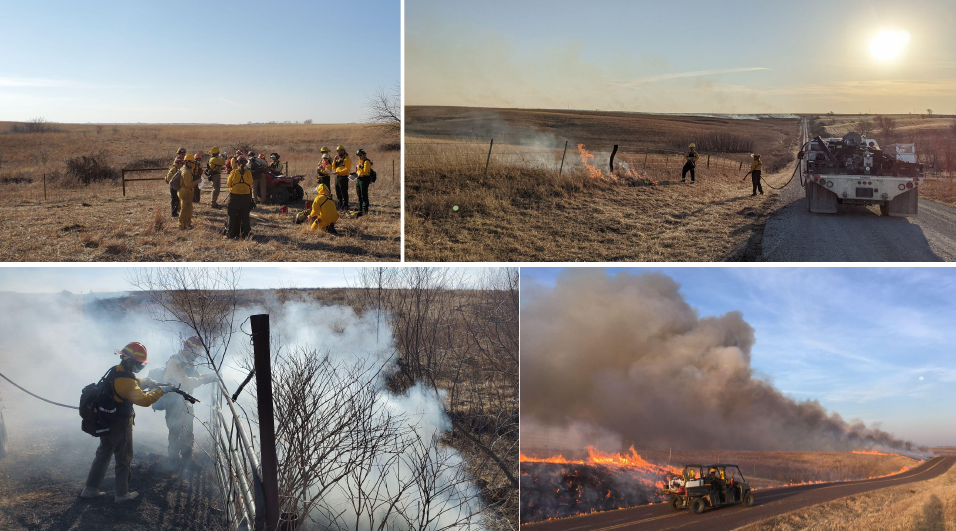
Figure 7. Workshop participants gained hands-on experience with prescribed fire as crew members burning two management units at Dunn Ranch Prairie. Clockwise from top left: The TNC RXB2 leads a briefing at the beginning of the first, 60-ha unit. Two course participants use a wet line from a TNC engine to burn out a fence line. Under supervision from a TNC line officer, a course participant uses water to limit the combustion of coarse woody debris in a ravine along the control line. Course participants patrol after setting a head fire from a county road along the 200 ha burn